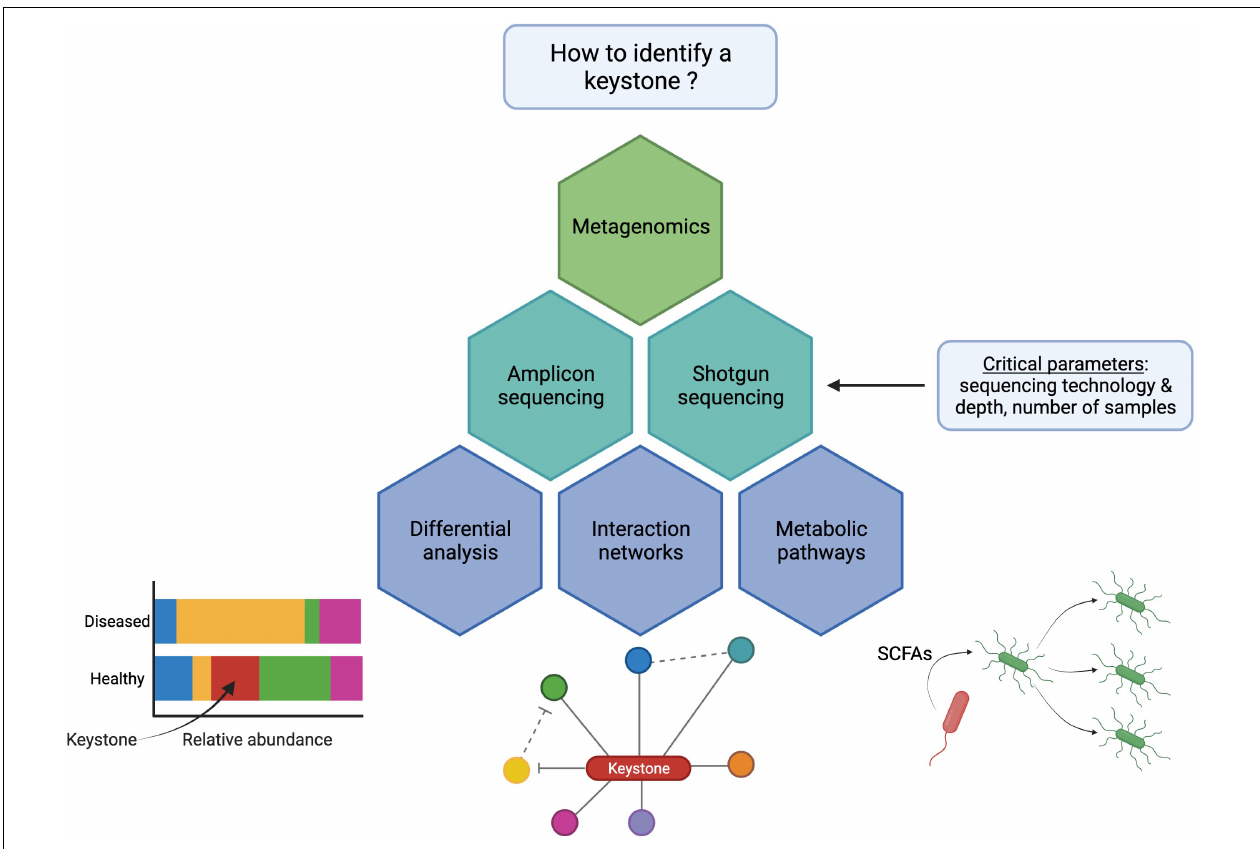
FIGURE 2 | Diagram of the most used bioinformatic strategies to identify microbiota keystone species using next-generation sequencing. The bacteria shown in red is a keystone species that disappears from the stool of patients in differential analyses (bottom left), is highly connected to other species through beneficial interactions (“hub”) (bottom middle), or produces essential metabolites (e.g., SCFAs) that enhance the growth of other bacteria (bottom right).